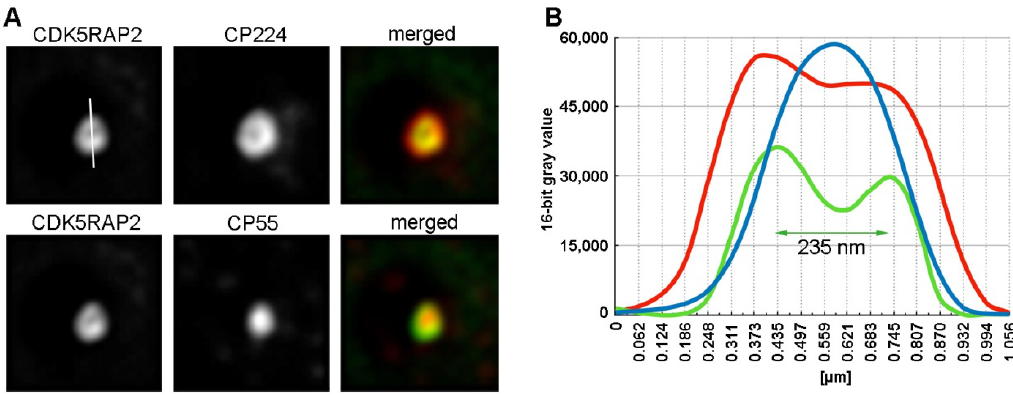
Figure 1. Subcentrosomal distribution of CDK5RAP2. Immunofluorescence deconvolution microscopy of AX2 control cells with rabbit anti-CDK5RAP2, rat anti-CP55 and mouse anti-CP224. Secondary antibodies against rabbit, rat and mouse antibodies were conjugated with AlexaFluor 568, AlexaFluor 488, and Cy5, respectively and cells were fixed with methanol. ( A ) The same representative centrosome is shown in all three channels as indicated. ( B ) Shows the corresponding intensity distributions for CDK5RAP2 (green), CP55 (blue) and CP224 (red) along the line shown in the upper left of ( A ). The diameter of the CP224 ring was slightly larger than that of the CDK5RAP2 ring, however, this may be due to the longer emission wavelength of the fluorescent dye coupled to the secondary antibody (Cy5 vs. AlexaFluor 568). As expected from its proposed involvement in microtubule organization, CDK5RAP2 is a component of the centrosomal